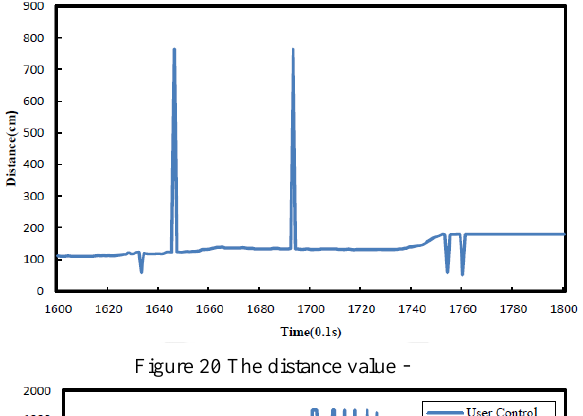
Figure 21 User control and System control-